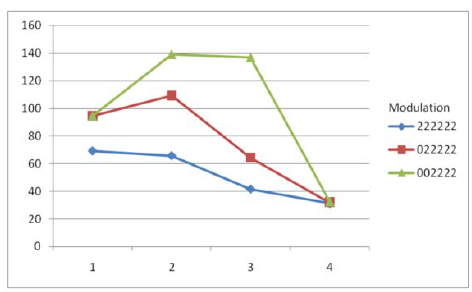
Figure 1. Three main modulations of spectral reflectance curve